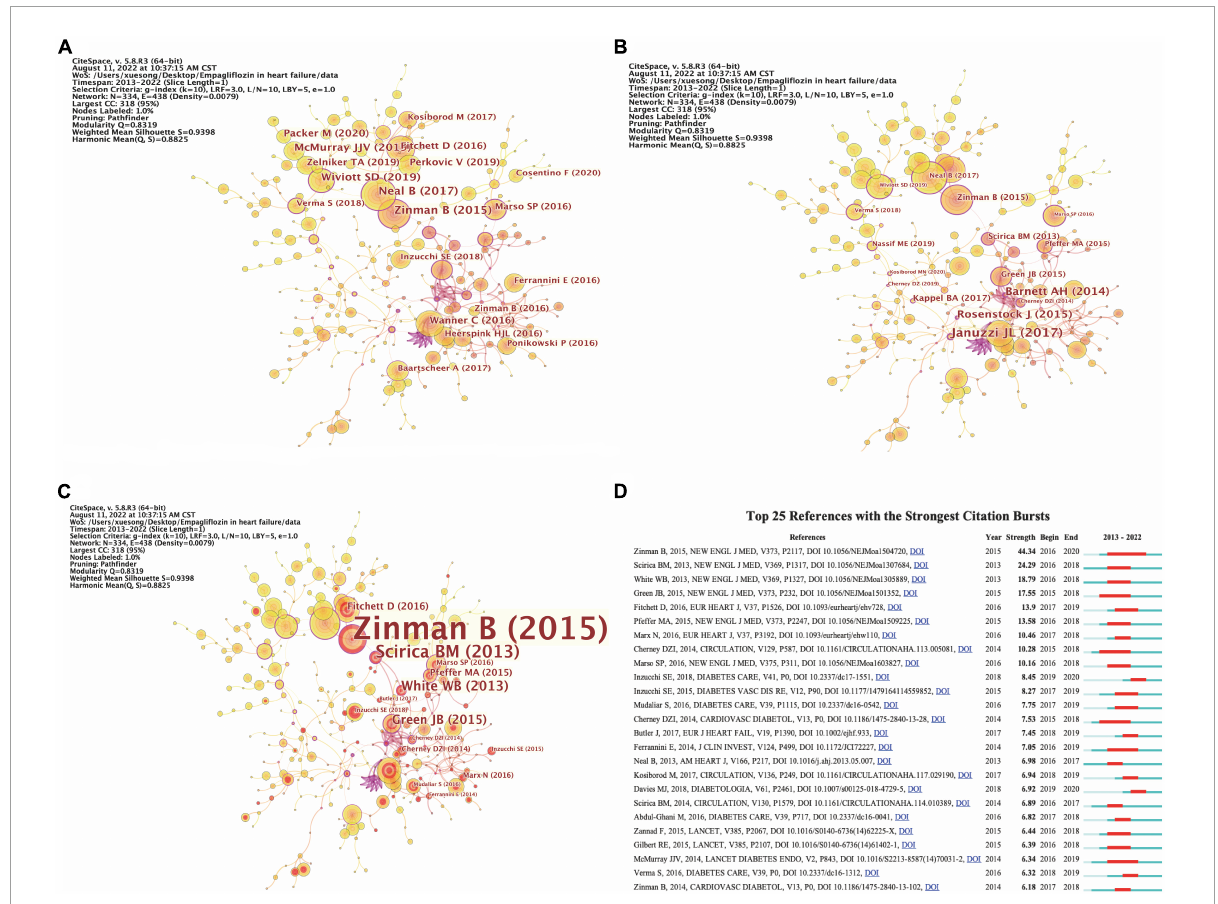
FIGURE4 The analysis of co-cited references. (A) The occurrence of co-cited references by citations. (B) The occurrence of co-cited references by centrality. (C) The occurrence of co-cited references by burst intensity. (D) The emergence of co-cited